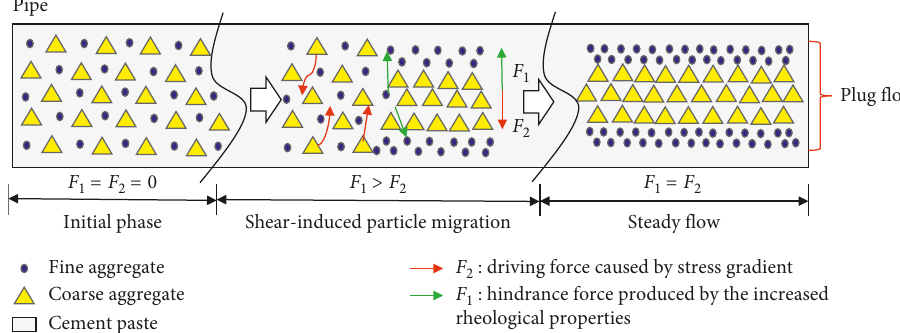
F 2 : driving force caused by stress gradient propertiesFine F 1 : hindrance force produced by the increased rheological Figure 14: Aggregate distribution of fresh concrete flowing in